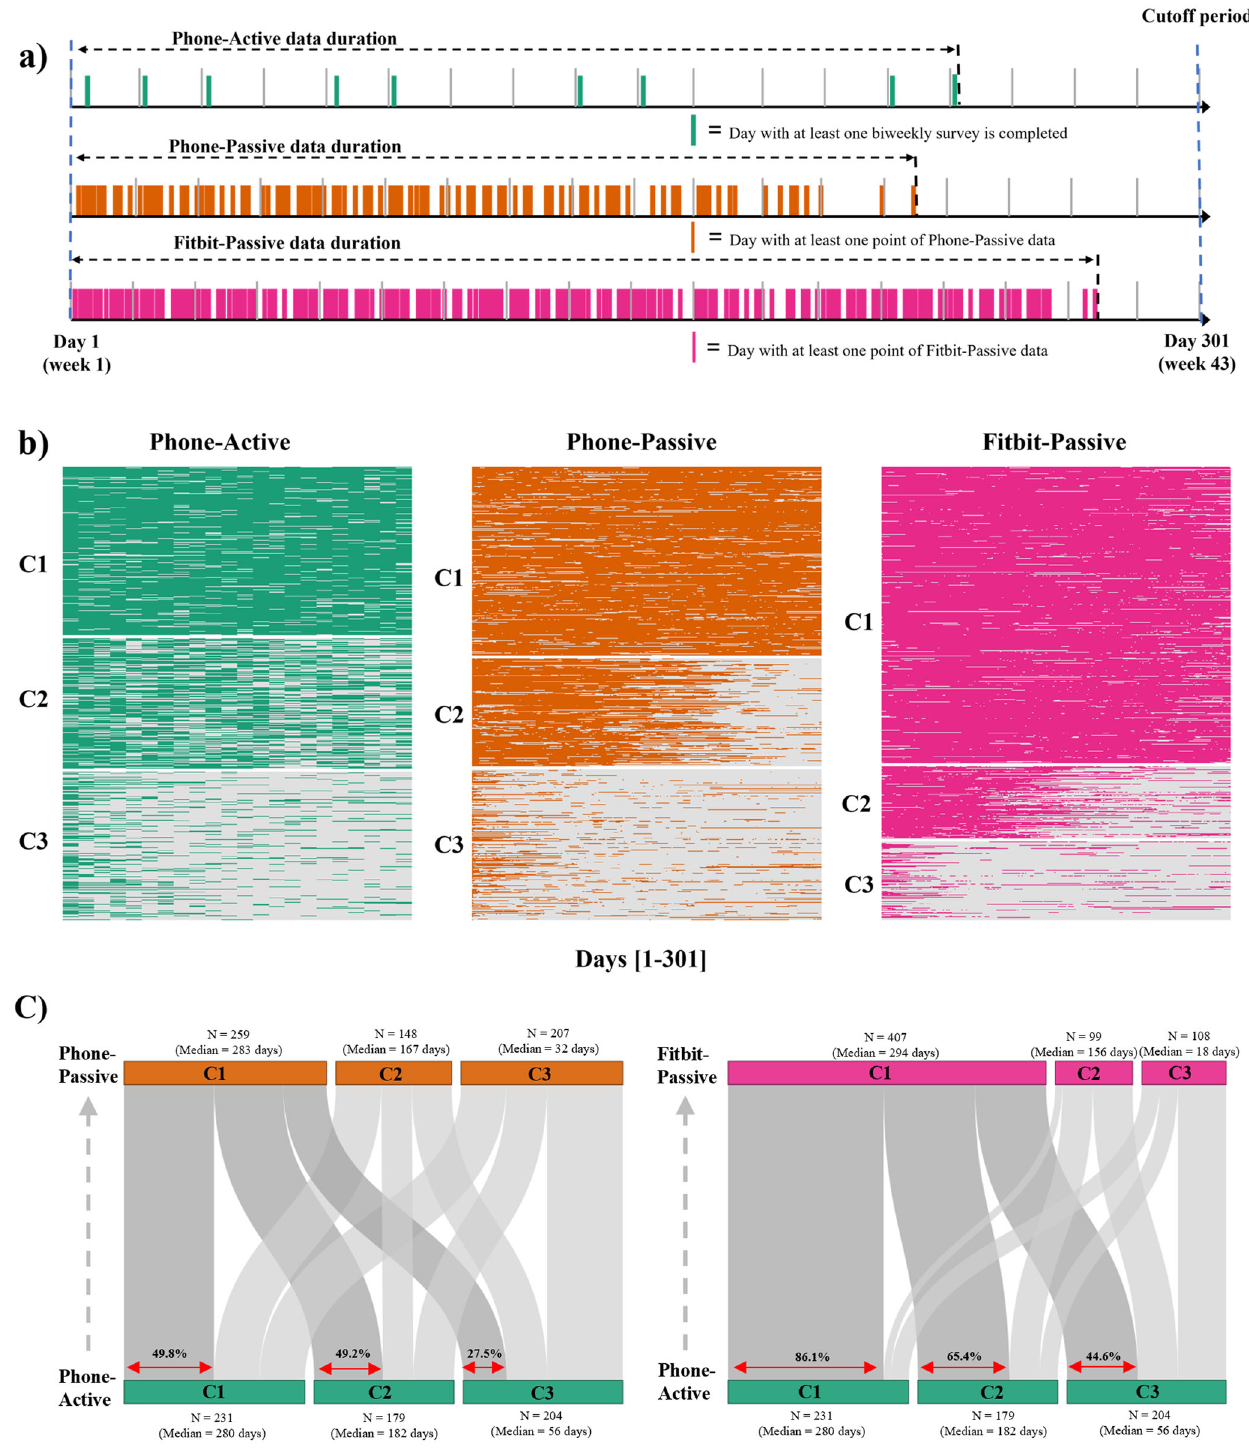
Fig. 2 Participant long-term engagement patterns in the RADAR-MDD dataset. a Schematic representation of a participant ’ s 3 data streams in the study. b Heatmaps of participant longitudinal engagement patterns, clustered using K-means clustering. In each heatmap, each row represents a data-availability vector of one participant (described in Methods), and subgroups were arranged from the most engaged cluster to the least engaged cluster (C1-C3). c Sankey plots showing the proportion of common participants between clusters determined from Phone-Active (green), Phone-Passive (brown), and Fitbit-Passive (pink) data streams. To match passive data streams, if a survey that was due every two weeks was completed by a participant, 14 elements of the participant ’ s data-availability vector of Phone-Active corresponding to these two weeks are set to 1 (representing the participant was contributing active data) (See “ Methods ” for further